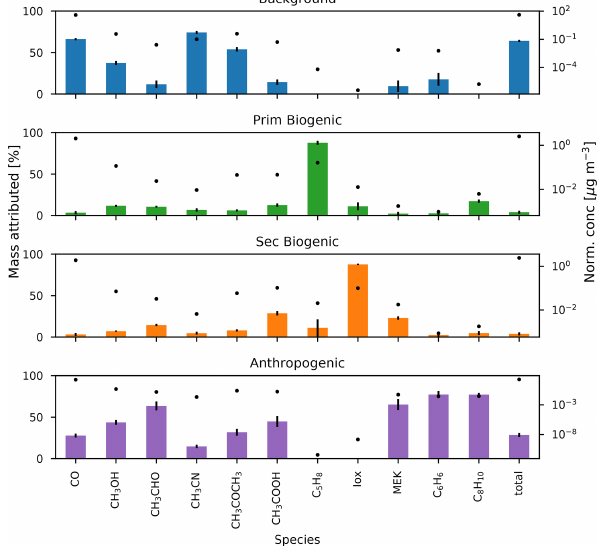
Figure 10. The median fraction of mass attributed (%) to the back- ground, primary biogenic, secondary biogenic, and anthropogenic factors calculated by the bootstrapping algorithm (bars, interquar- tile distance shown by error bars) and the median normalized con- centration (µgm − 3 ) of the factor profiles